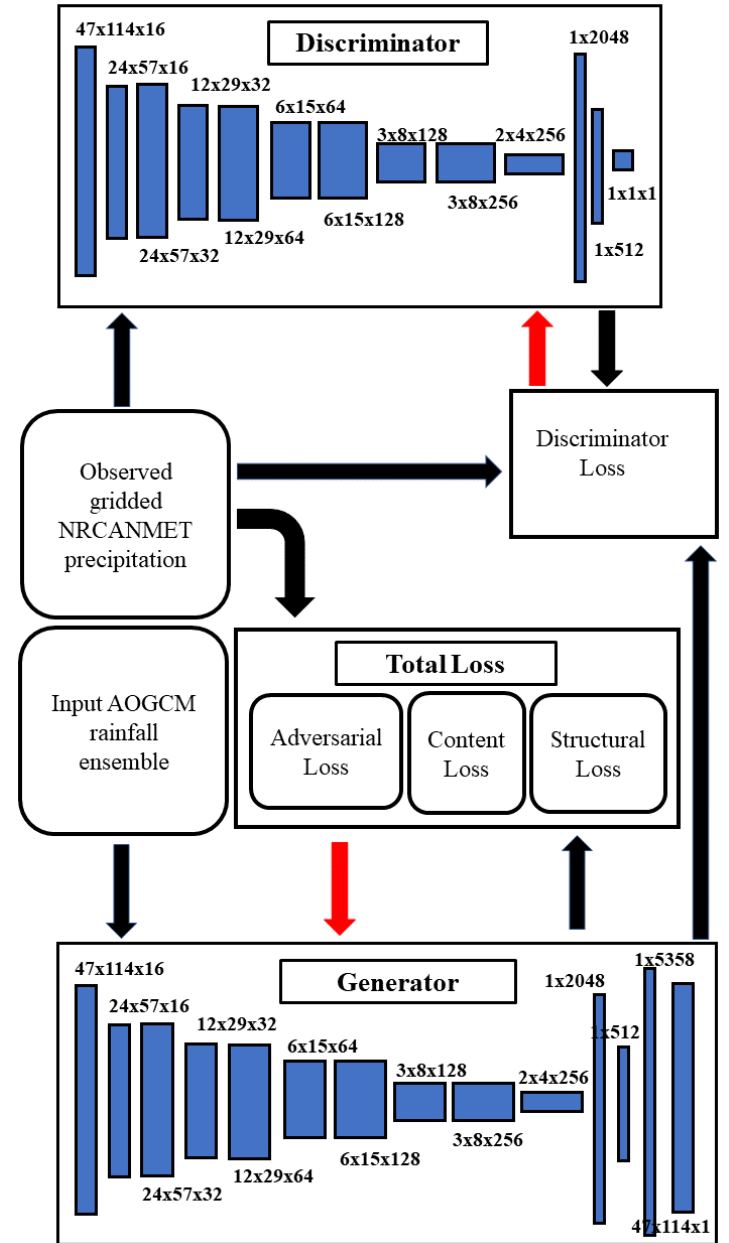
Figure 2. Schematic of the generative adversarial network.